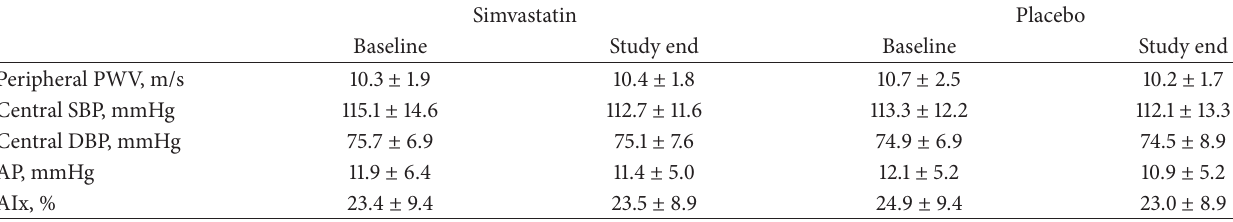
Table 3: Arterial stiffness changes by drug assignment a,b